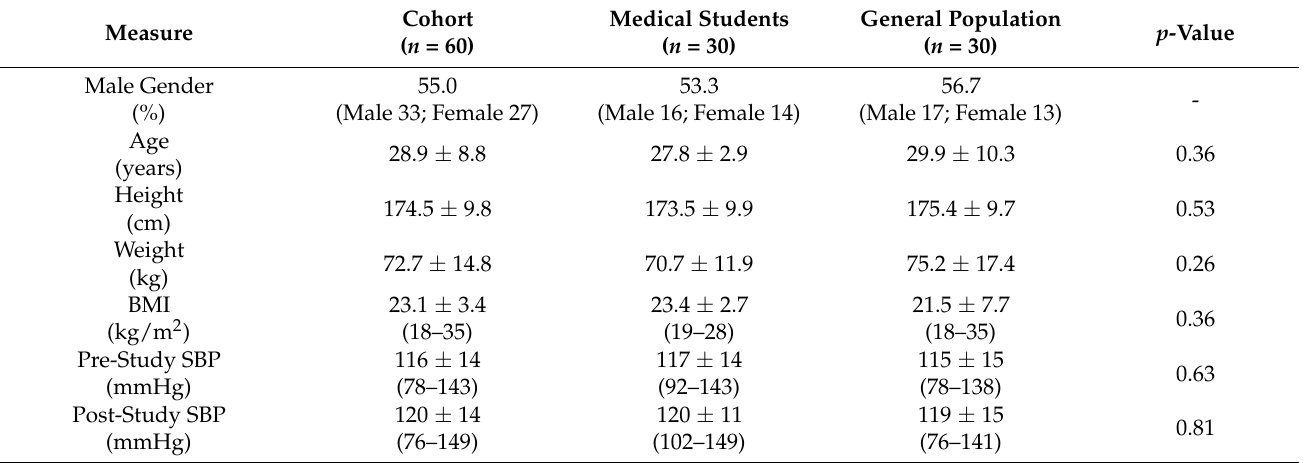
Demographics and blood pressure data for the cohort and per grouped division (mean ± standard deviation with range in parentheses). Comparisons are between medical stu- dent and general population (Student’s unpaired t